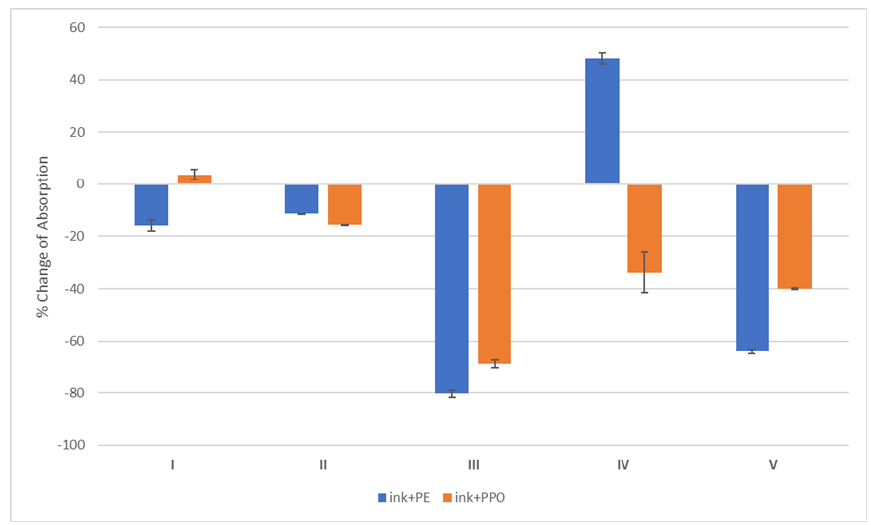
Figure 2. The percentage of change of the aqueous solution of each ink after mixing them with PE ( ■ ) or PPO ( ■ ) and incubation at 37 °C for 60 min ( p < 0.05). The results indicate that the best decolorization potential of PE and PPO was achieved on PMU inks that mainly contained inorganic colorants (inks III, V). On the con- trary, the decolorization action on organic colorants (inks I, II) appeared weak.